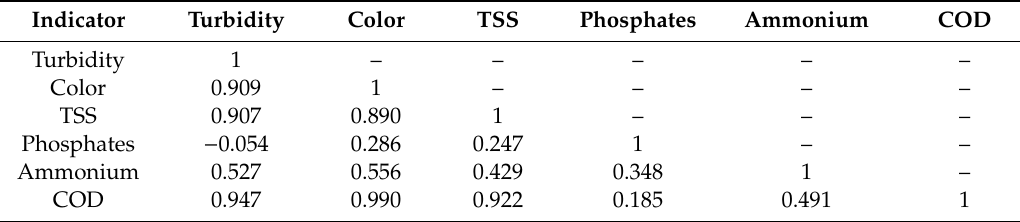
Table 5. Correlation of some physicochemical parameters from the Al–Gr